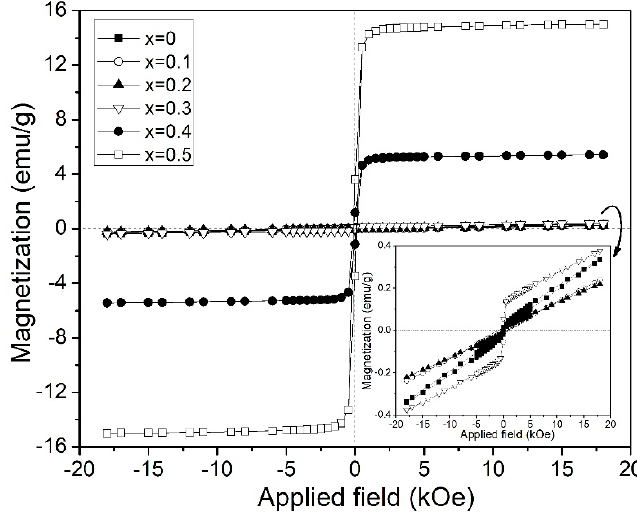
Figure 3. Magnetic hysteresis loops at room temperature of Y 1 − x Bi x FeO 3 (0 ≤ x ≤ 0.5 ∆ x = 0.1) sintered at 700 °C samples. The inset shows a magnification of hysteresis for 0 ≤ x ≤ 0.3 samples .